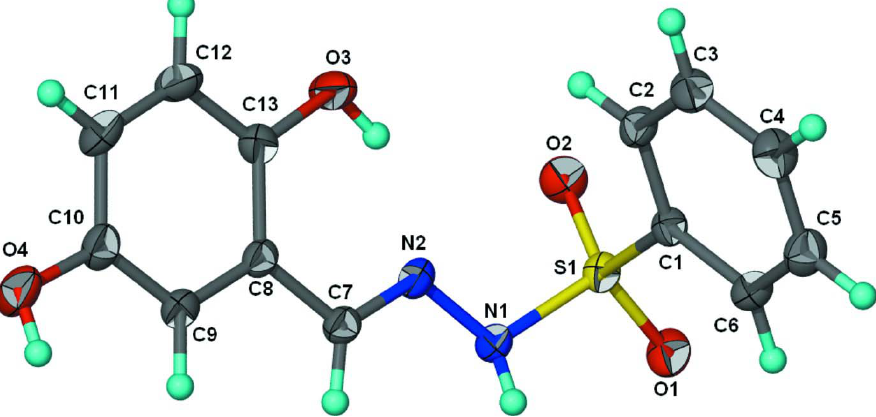
Molecular structure of the title compound. Displacement ellipsoids are drawn at the 70% probability level, and H atoms are shown as spheres of arbitrary